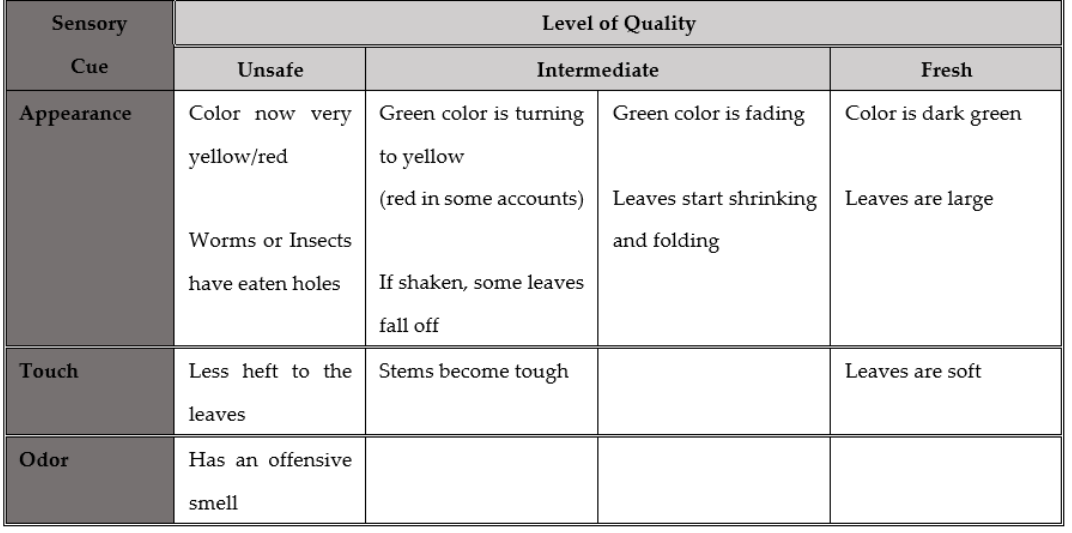
Figure 2. Vendors’ typology of GLV quality.